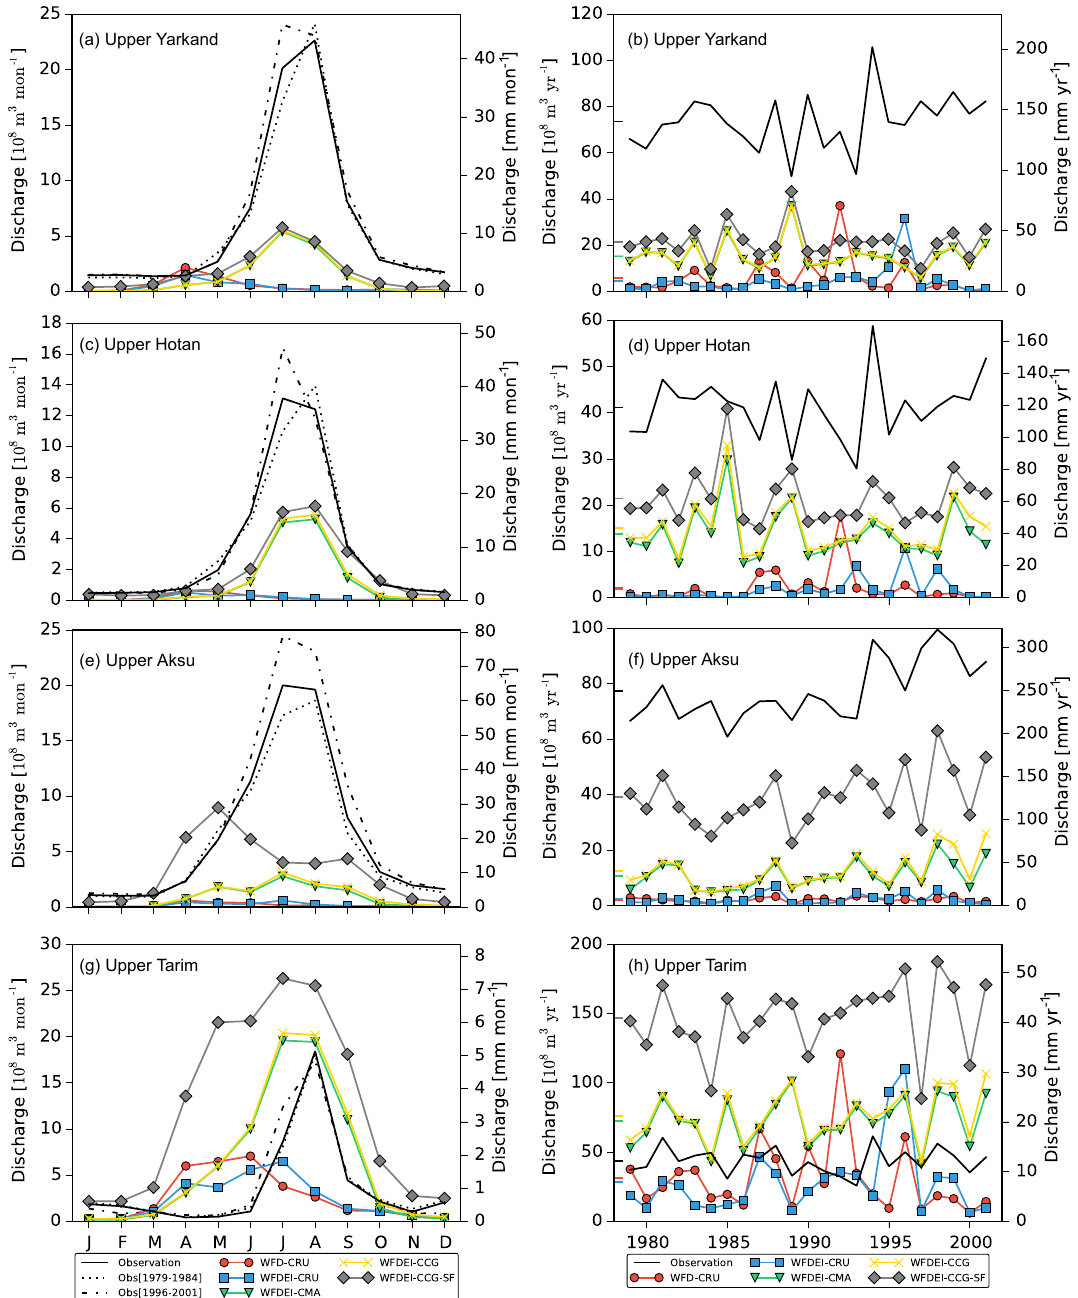
Figure 6. The interannual cycle and intra-annual series of the discharge simulation for three headwater catchments and the upper Tarim Basin: (a, b) Yarkand River, (c, d) Hotan River, (e, f) Aksu River and (g, h) the upper Tarim Basin. Observed discharge for each subbasin was aggregated by the measurements at separated discharge gauges and shown as the black solid line. The simulated discharges at the corresponding grids were extracted from each experiment and plotted as the color lines with markers. The dotted line and dot-dash line in the interannual cycle plots represent the observed discharge in different